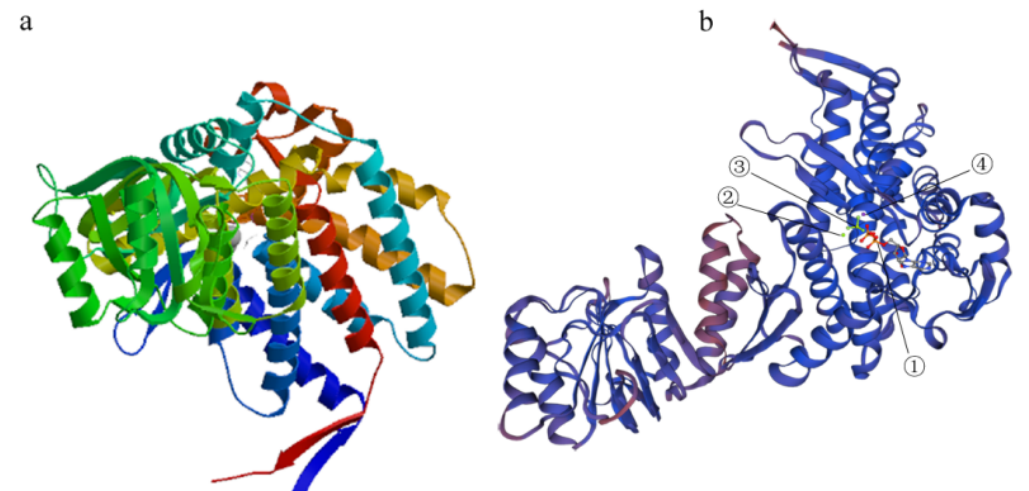
Figure 3. The 3D-structural models of Sp HSP60 and binding site prediction: ( a ) indicates the 3D- structural models of Sp HSP60; ( b ) indicates binding site prediction. ① Adenosine-5 ′ -diphosphate binding site, ② magnesium ion binding site, ③ beryllium trifluoride ion binding site, ④ potassium ion binding site.